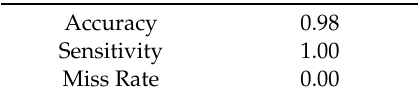
Table 3. Convolutional neural network